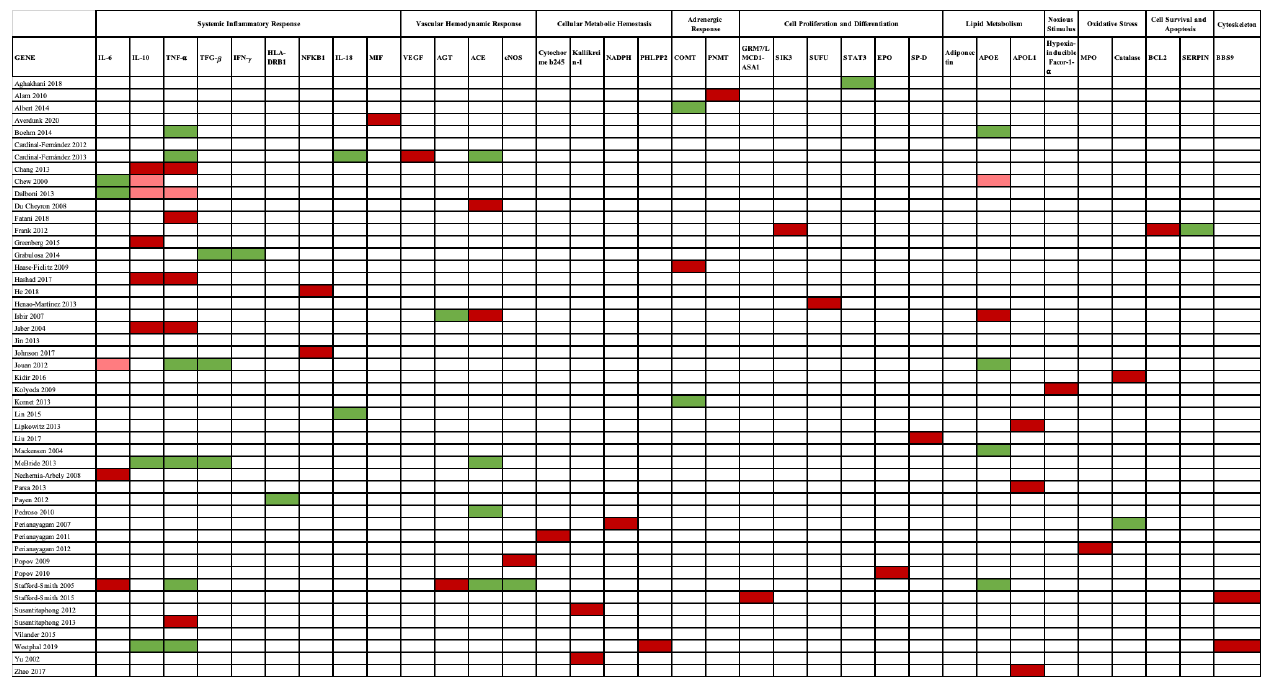
Figure 4. Genes and AKI susceptibility relationship. A red color pinpoints the genes associated with AKI, in which a dark red color highlights a strong association, while a light red color indicates a weak association. No association is marked by a green color. Genes are presented according to the mechanism involved in AKI pathogenesis. Abbreviations: ACE, angiotensin-converting enzyme gene; AGT, angiotensinogen gene; APOE, apolipoprotein E gene; BCL-2, B-cell CLL/lymphoma 2 gene; BBS9, Bardet–Biedl syndrome 9 gene; CAT, catalase gene; COMT, catechol-O-methyltransferase gene; eNOS, endothelial nitric oxide synthase gene; EPO, erythropoietin gene; HIF1- α , hypoxia-inducible factor 1- α gene; HLA-DRB1, human leukocyte antigen–major histocompatibility complex, class II, DR beta 1 gene; IFN- γ , interferon- γ gene; IL-6, interleukin-6 gene; IL-18, interleukin-18 gene; IL-10, interleukin-10 gene; MIF, macrophage migration inhibitory factor gene; MPO, myeloperoxidase gene; NADPH, nicotinamide adenosine dinucleotide phosphate gene; NF κ B, nuclear factor- κ B gene; PHLPP2, PH domain and leucine-rich repeat protein phosphatase 2 gene; PNMT, phenylethanolamine N-methyltransferase gene; SERPINA, serpin peptidase inhibitor, clade A ( α -1 antiproteinase, antitrypsin) gene; SIK3, salt-inducible kinase 3 gene; SP-D, surfactant protein-D gene; STAT3, transducer and activator of transcription 3 gene; SUFU, suppressor of fused homolog gene; TGF- β , transient growth factor- β gene; TNF- α , tumor necrosis factor α gene; VEGF, vascular endothelial growth factor